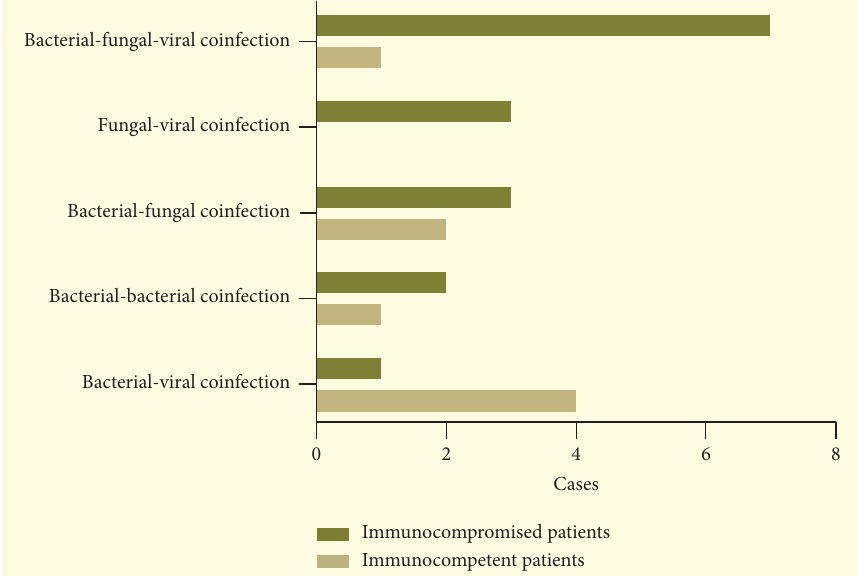
Figure 4: Common combinations of mixed infections in immunocompromised and immunocompetent patients with